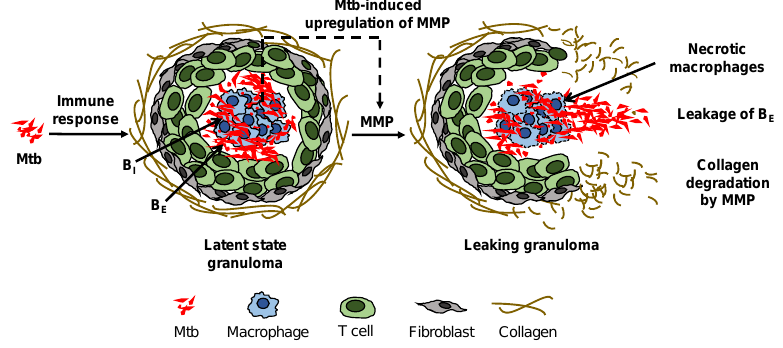
Figure 1. Mycobacterium tuberculosis (Mtb) induces an immune response in the lungs of a host that can lead to formation of a cellular aggregate called a granuloma in which the Mtb can remain dormant in the condition of latent tuberculosis (TB). Direct and indirect upregulation of matrix metalloproteinase (MMP), which is stimulated by the Mtb in infected macrophages in the granuloma and denoted by a dashed arrow, degrades the collagen exterior of the granuloma, triggering leakage of extracellular bacteria ( B E ) and formation of a necrotic leaking granuloma called a TB